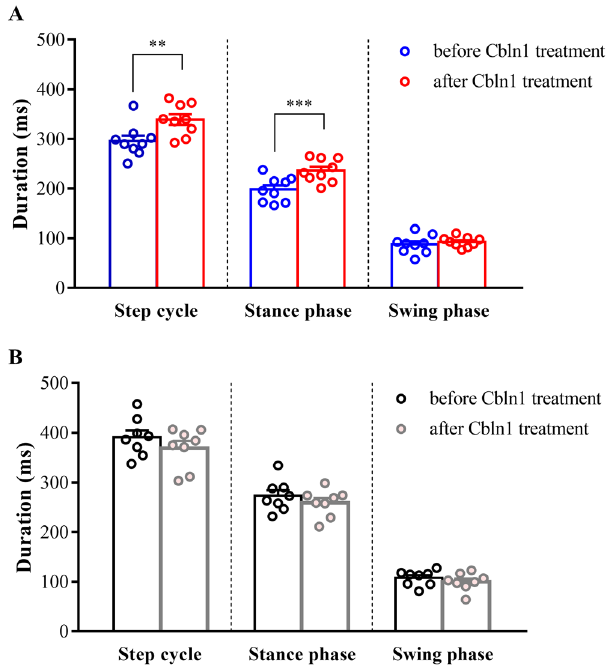
Figure 5. Average step cycle duration after injection of Cbln1. ( A ) Average step cycle, stance and swing phase durations in cbln1 -null mice before (before treatment, blue) and after (Cbln1-treated, red) injection of Cbln1. ( B ) Average step cycle, stance phase and swing phase durations in wild-type mice before (before treatment, black) and after (Cbln1-treated, gray) injection of Cbln1. Differences in durations before and after injection of Cbln1 were tested using paired t -tests. ** p < 0.01, *** p <